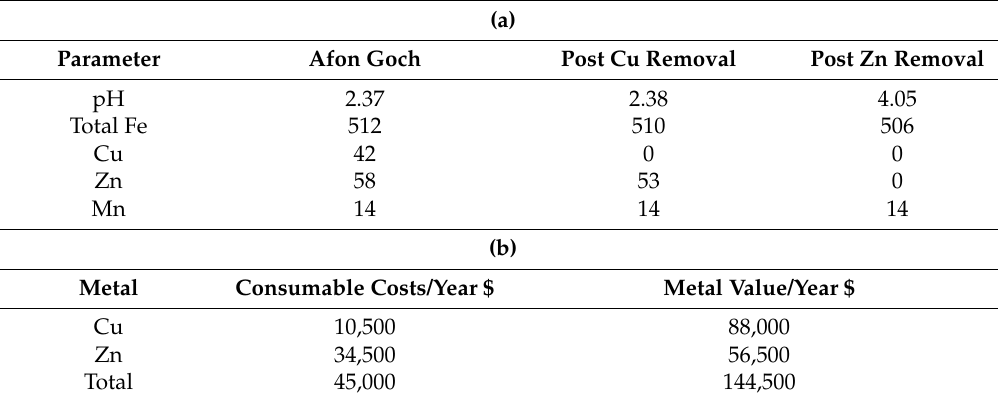
Table 2. ( a ) Concentrations of the major transition metals present in the Afon Goch (in mg/L) and those remaining after the selective precipitation of copper and zinc (as sulfide phases); ( b ) comparison of reagent costs and metal values in the proposed recovery of copper and zinc from the mine water using